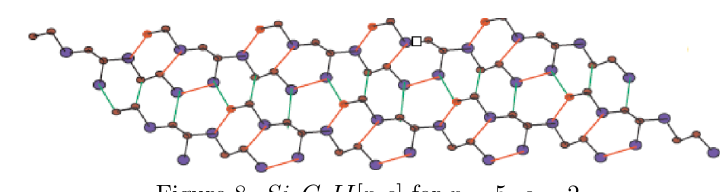
Figure 8. Si 2 C 3 II [ r, s ] for r = 5, s =